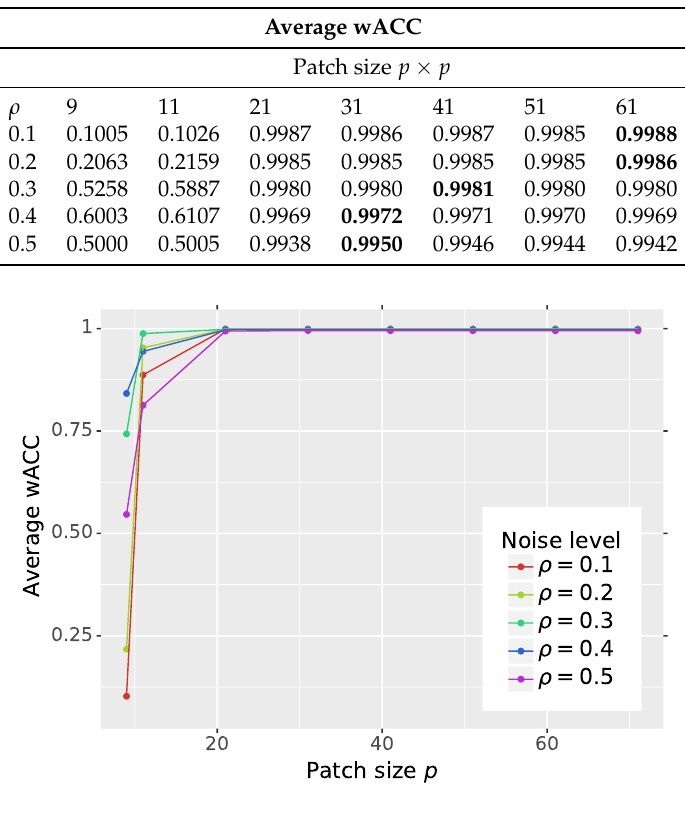
Figure 7. Impact of the patch size p used in the training procedure on the network’s weighted detection accuracy.